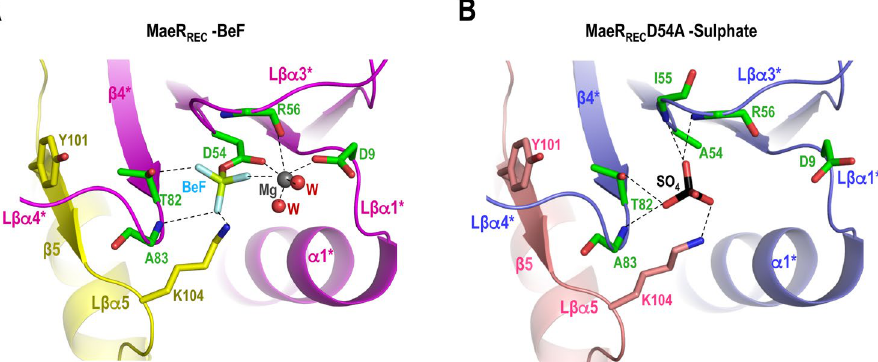
Figure 5. Active site organization of MaeR REC wild-type and D54A mutant. ( A ) Cartoon representation of the active site in the REC domain of wild-type MaeR structure showing as sticks the catalytic residues as well as the BeF 3 − (carbons in green for the magenta coloured monomer and in yellow for the yellow coloured monomer; nitrogen, oxygen, beryllium and fluor in blue, red, pale-green and cyan, respectively). The magnesium ion (in grey) and the water molecules (in red) that stabilize the active site are also shown. ( B ) Cartoon representation as in A of the active site in the mutant D54A with the presence of a sulphate ion in the active site. Catalytic residues are shown as sticks (carbons in green for the blue coloured monomer and in pink for the pink coloured monomer; sulfur in